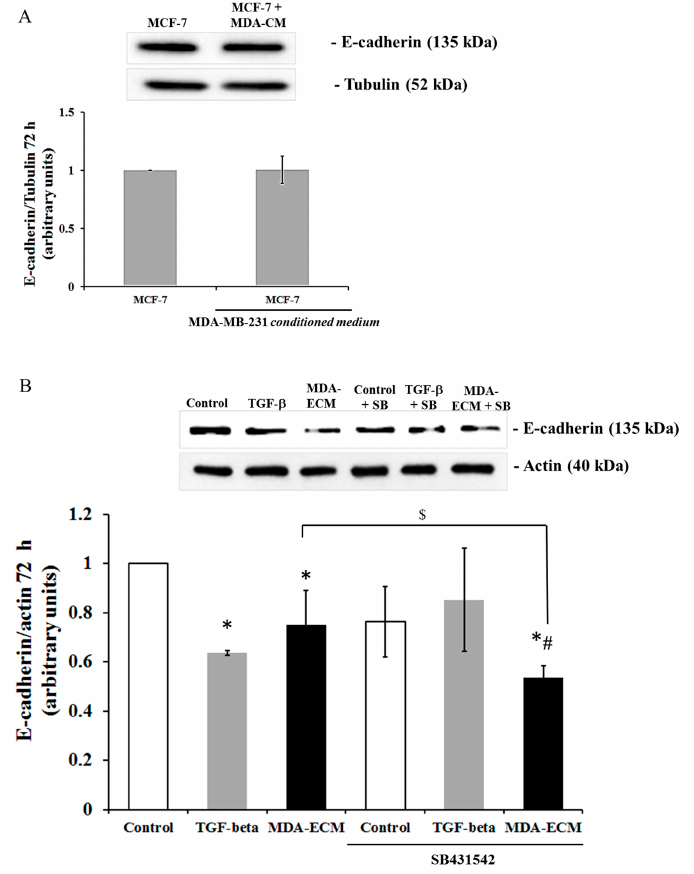
Figure 4. MDA-MB-231-derived ECM decreased E-cadherin expression in MCF-7 cells independent of TGF-beta receptor activation. MCF-7 and MDA-MB-231 cells were cultured in standard conditions for 72 h, and decellularized ECMs were obtained, as described in the Methods. ( A ) MCF-7 were seeded on their own matrix for 72 h with or without conditioned medium from MDA-MB-231 cultures. Cell lysates were immunoblotted with anti-E-cadherin and anti-tubulin antibodies. ( B ) MCF-7 cells were seeded on decellularized MCF-ECM with or without TGF- β 1 or MDA-ECM in the presence or absence of the TGF- β receptor inhibitor SB431542 (15 µg/mL) for 72 h. Cell lysates were immunoblotted with anti-E-cadherin and anti-actin antibodies. The results are shown as the mean fold increase relative to the MCF-ECM (* p < 0.05); MCF-ECM treated with SB431542 (# p < 0.05) and MDA-ECM without inhibitor ($ p < 0.05) were calculated from 3 individual experiments.